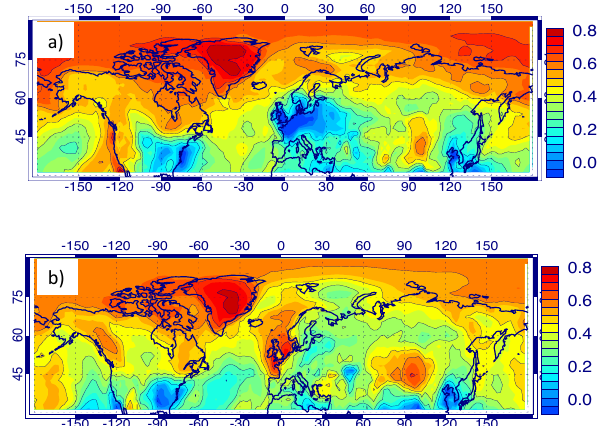
Figure 12. As in Fig. 11 but for the normalized first EOF compo- nent of detrended ozone at the surface for two different ensemble